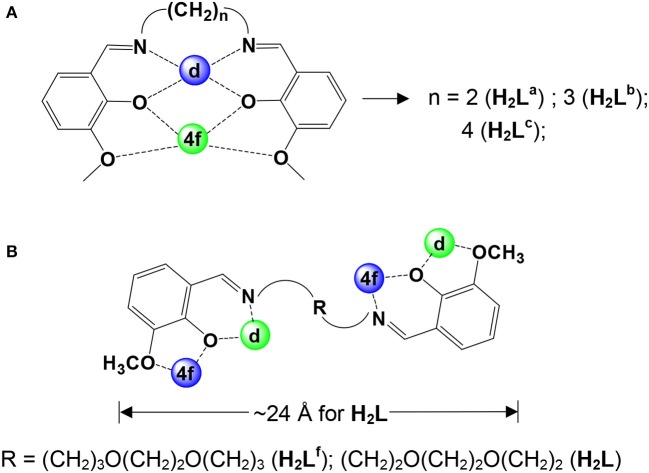
(A)“Bending” configuration of H2La−e; (B)“Linear” configuration of H2Lf and H2L.